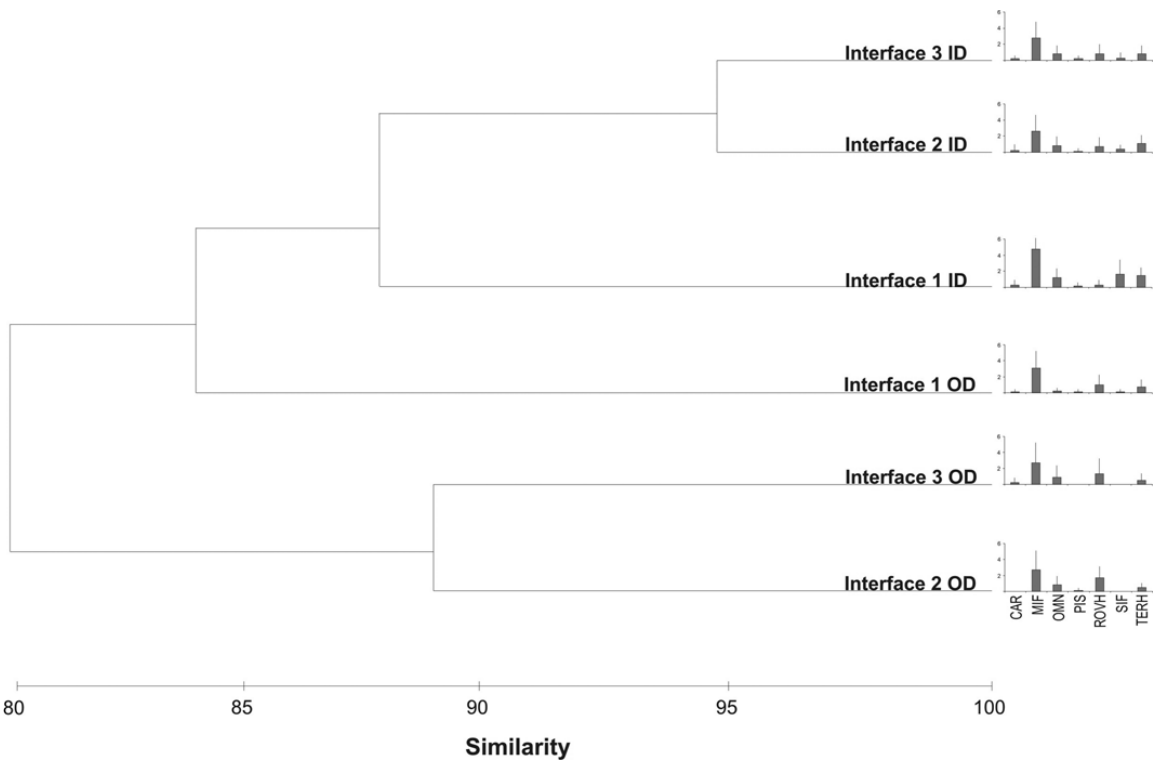
Fig. 10 – Similarity cluster analysis of trophic guilds among OD and ID patches on interface zones of Maramutá reefs. CAR = carnivore; MIF = Microinvertebrate feeder; OMN = Omnivore; PIS = Piscivore; ROVH = Roving Herbivore; SIF = Sessile Invertebrate feeder; TERH = Territorial